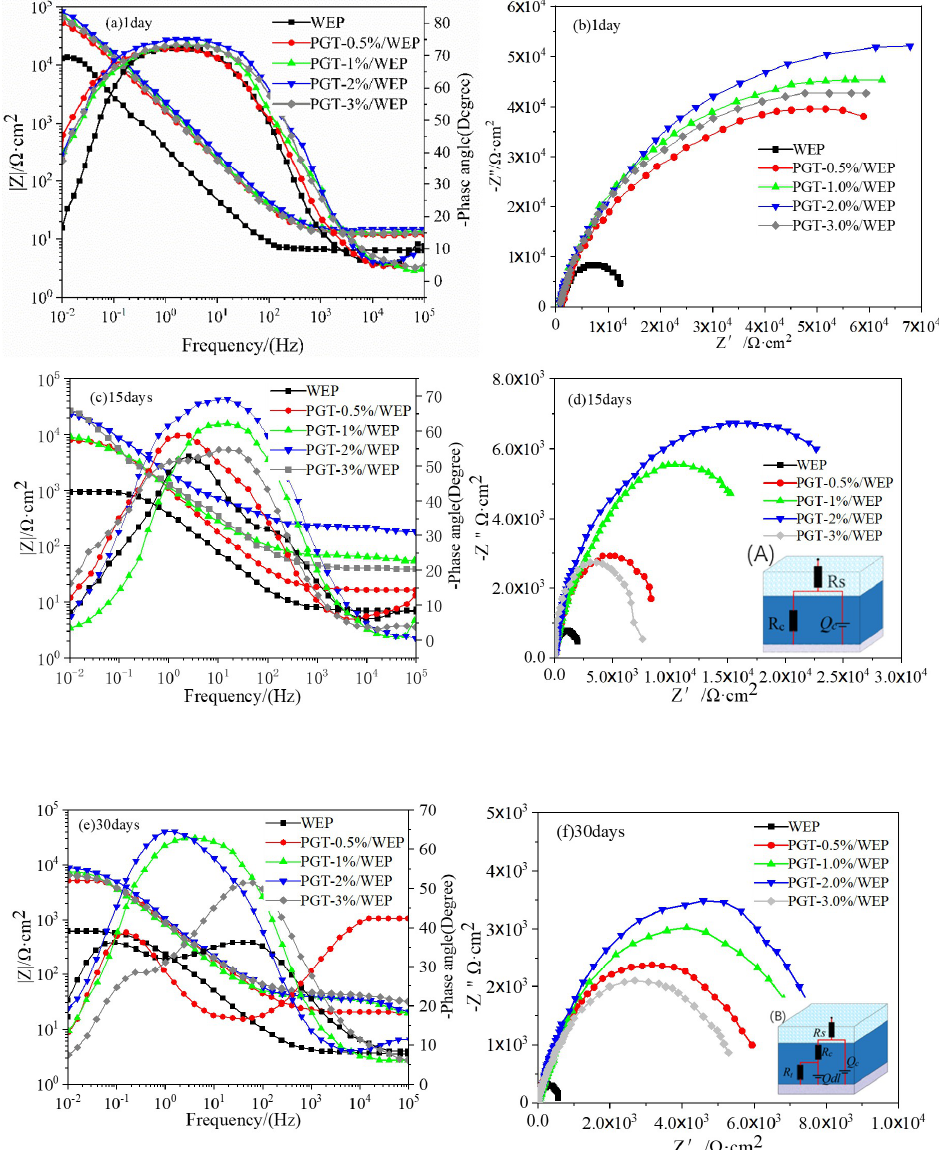
Figure 11. Bode impedance diagram, Bode phase diagram and Nyquist diagram of PGT/WEP coating soaked for 1 day, 15 days, and 30 days, respectively. (A), (B) The equivalent